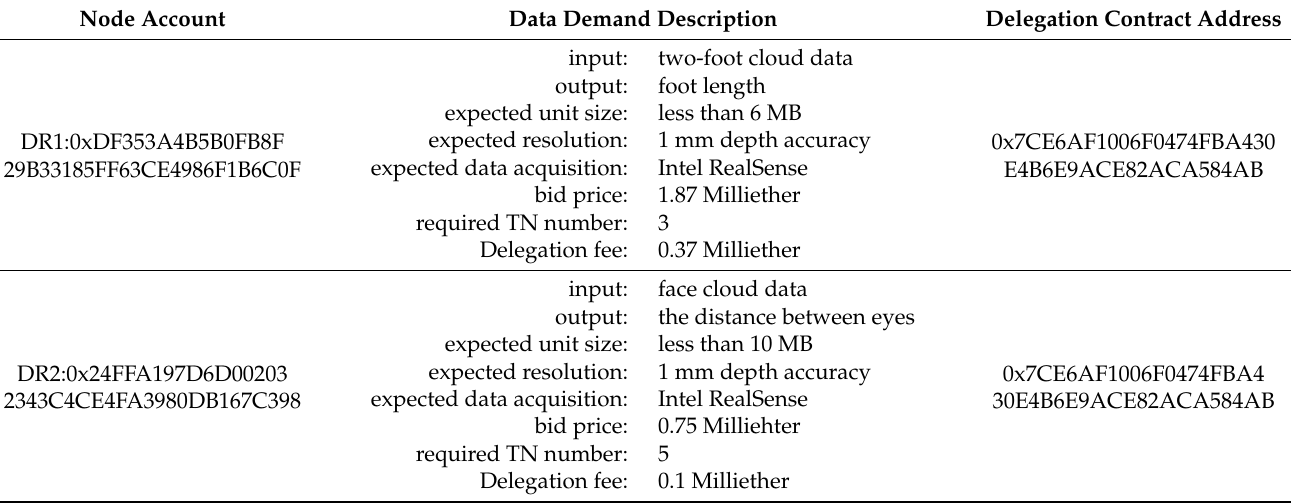
Table 3. The DR data demand information.